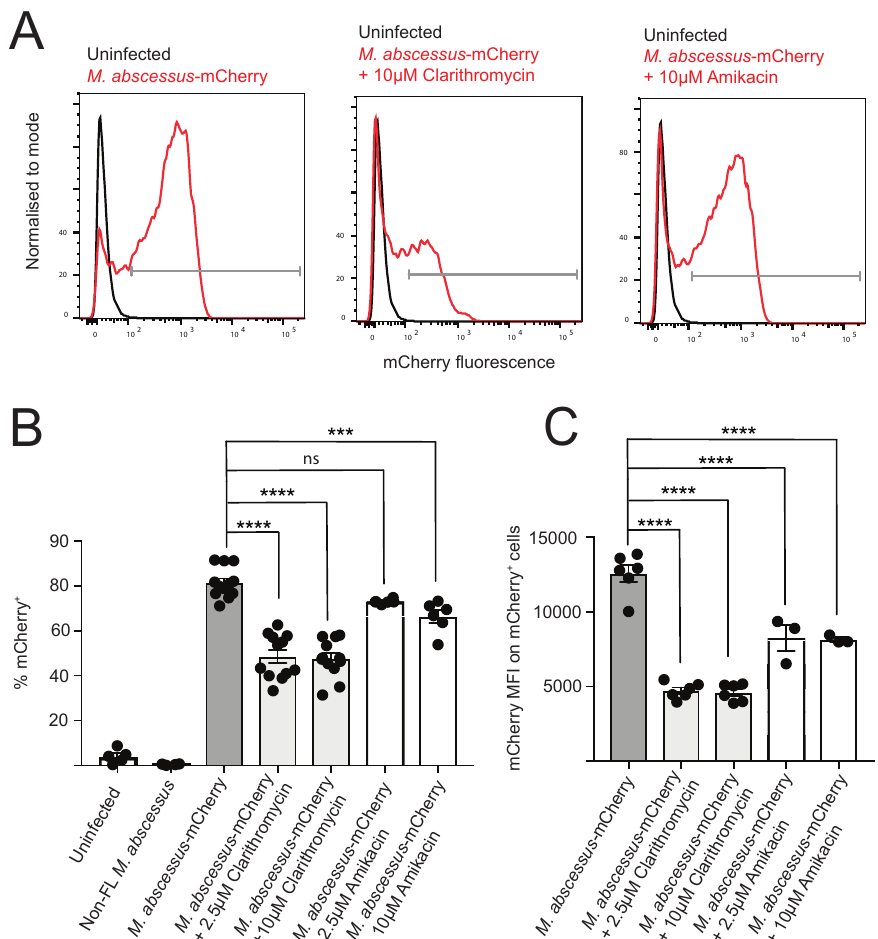
Figure 1. Single cell analysis of M. abscessus -mCherry infection and drug susceptibility using conventional flow cytometry. J774 macrophages were infected with M. abscessus -mCherry for 4 h, followed by 24 h culture with or without the indicated antibiotics. ( A ) Representative flow cytometry plots, ( B ) % of mCherry positive cells, and ( C ) mCherry MFI on mCherry +